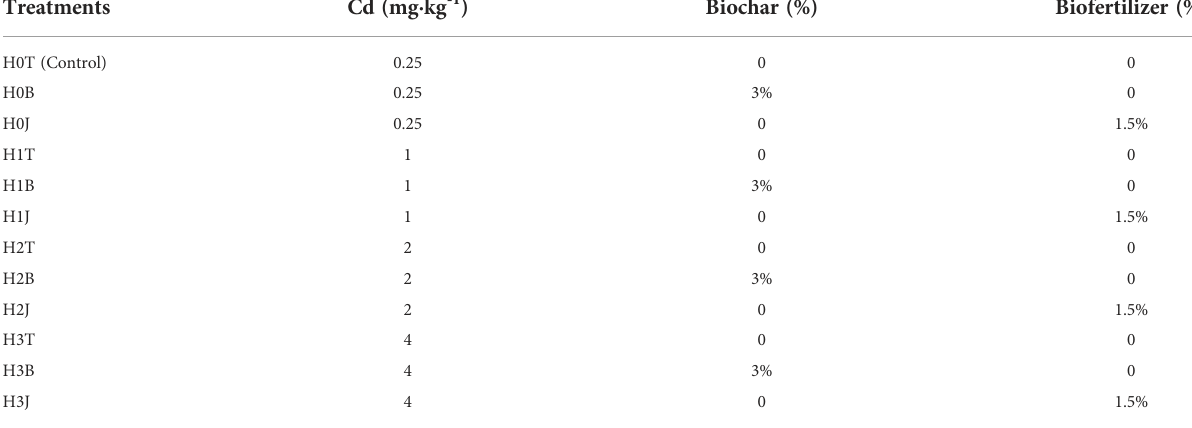
TABLE 2 Experimental